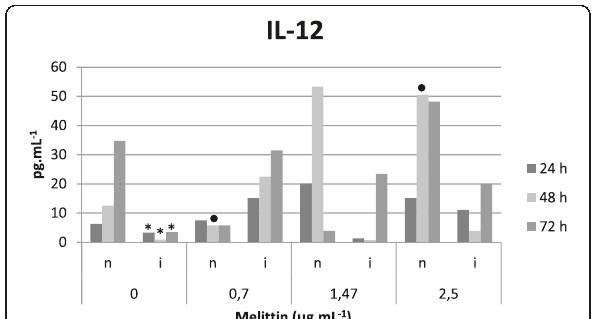
Fig. 2 Determination of IL-12 concentration (pg.mL − 1 ) in the supernatant of uninfected macrophages ( n ) and infected macrophages ( i ) after melittin treatment (0, 0.7, 1.47 and 2.5 μ g.mL − 1 ) at 24, 48 and 72 h. Data are presented as mean of three independent measurements. * p <0.05 for infected cells versus non-infected cells (24, 48 and 72 h) without melittin addition. ● p <0.05, for 24 h treatment with 2.5 versus